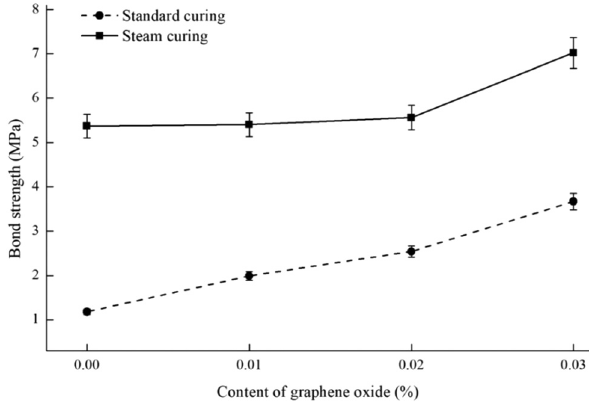
Figure 9: Bond strength between a single fi ber and the bulk matrix of UHPC at 7 days.